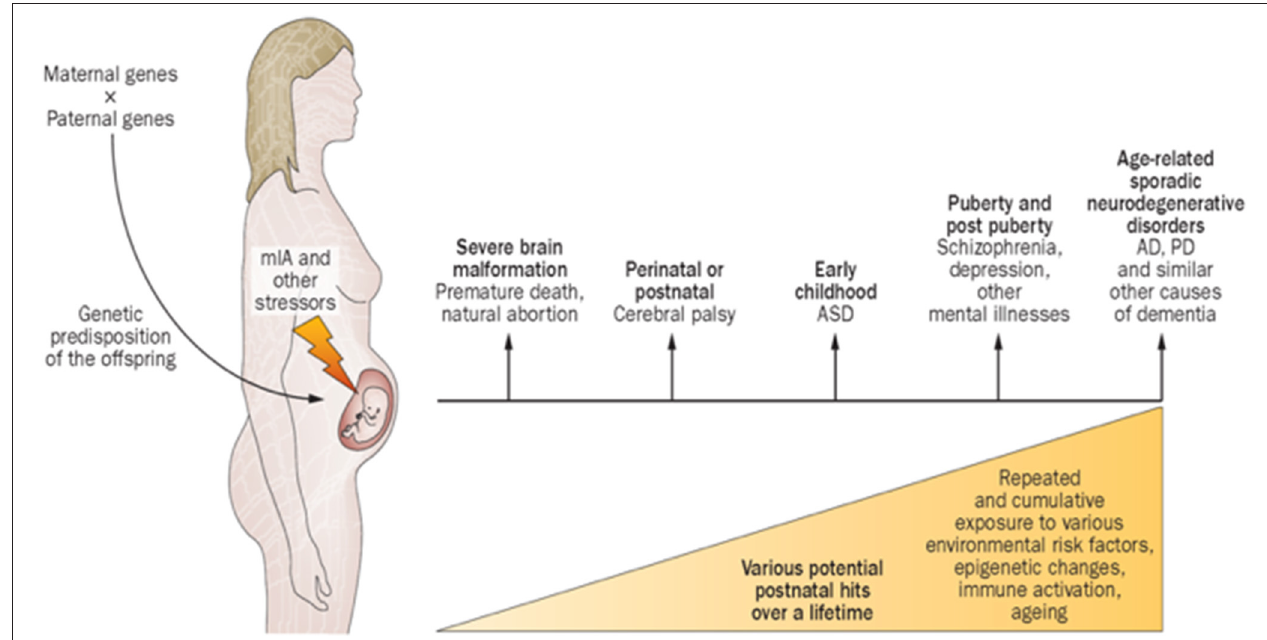
FIGURE 3 | Proposed causal chain of events with mIA in humans, leading to a wide spectrum of neuronal dysfunctions and behavioral phenotypes observable in the juvenile, adult, or aged progeny. AD, Alzheimer disease; ASD, autism spectrum disorder; mIA, maternal immune activation; PD, Parkinson disease ( 42).